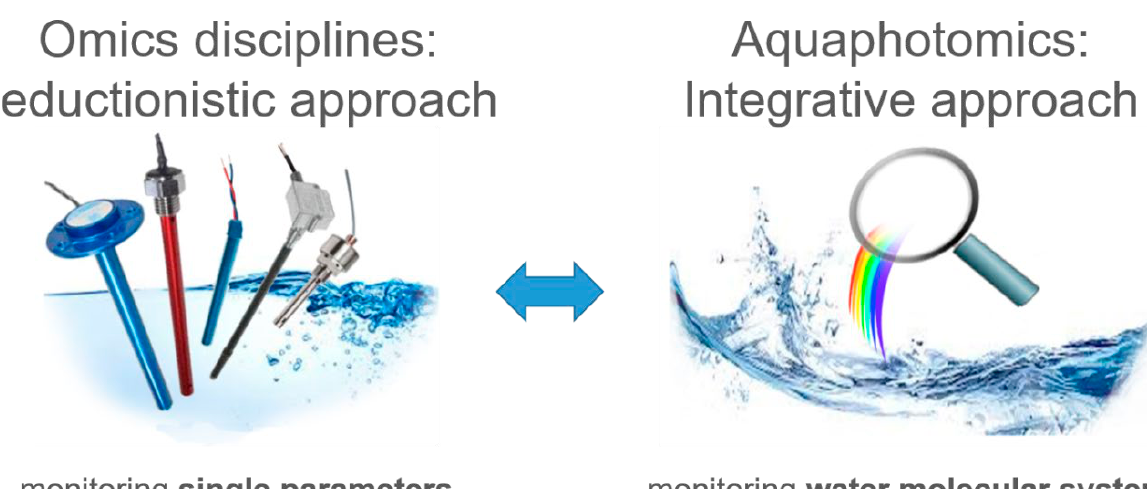
Figure 3. Aquaphotomics encompasses all other “omics” disciplines, providing an integrative approach to studying aqueous and biological